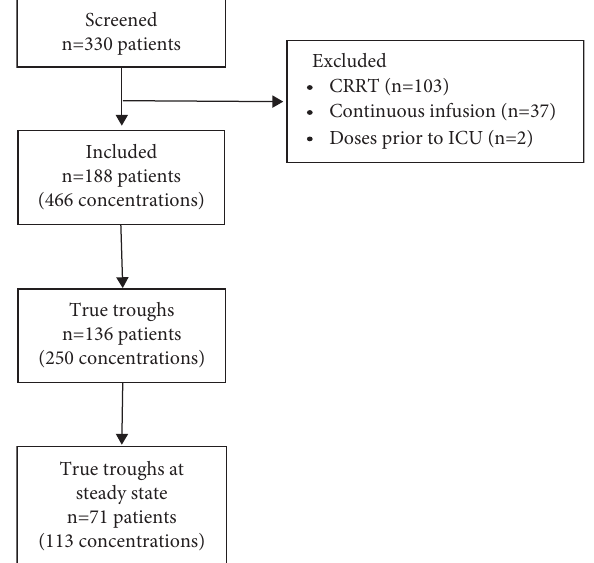
Figure 1: Flow diagram of sample selection. CRRT � continuous renal replacement therapy; ICU � intensive care